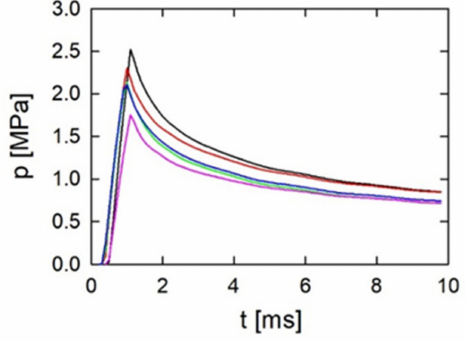
Figure 8. Pressure courses were recorded for the chamber filled with 4 mm glass spheres.